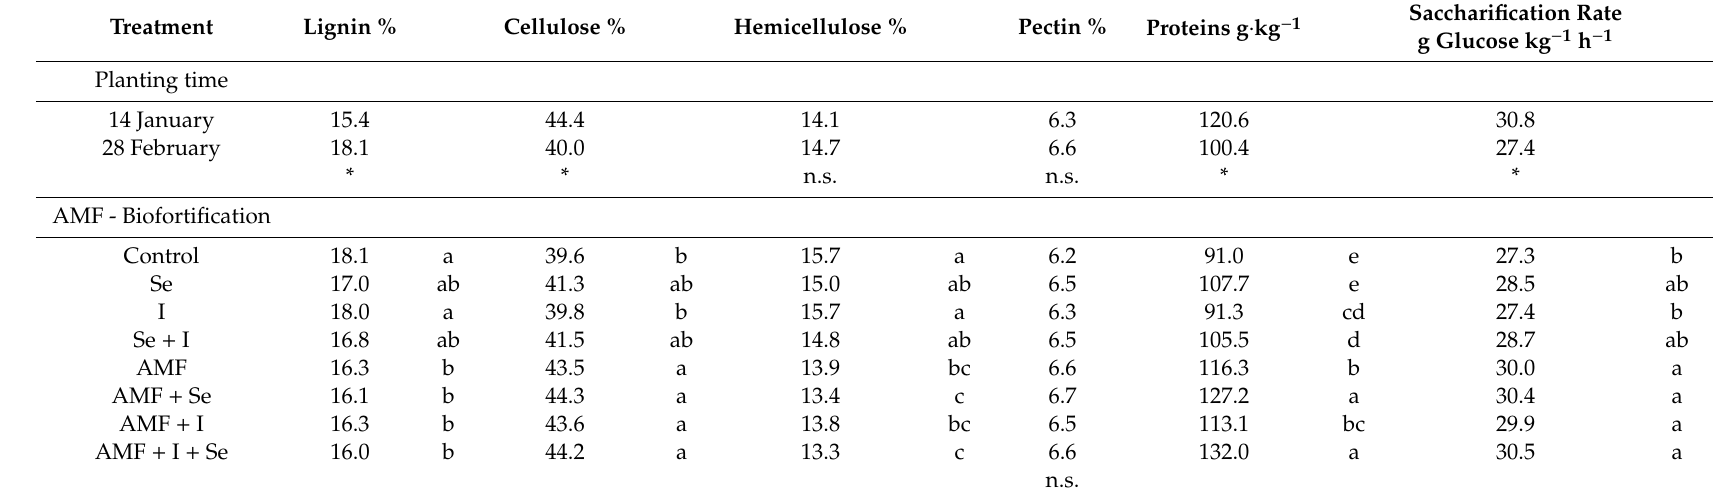
Table 7. Chemical composition of chickpea residual biomass as a ff ected by planting time and AMF - biofortification. Treatment Planting